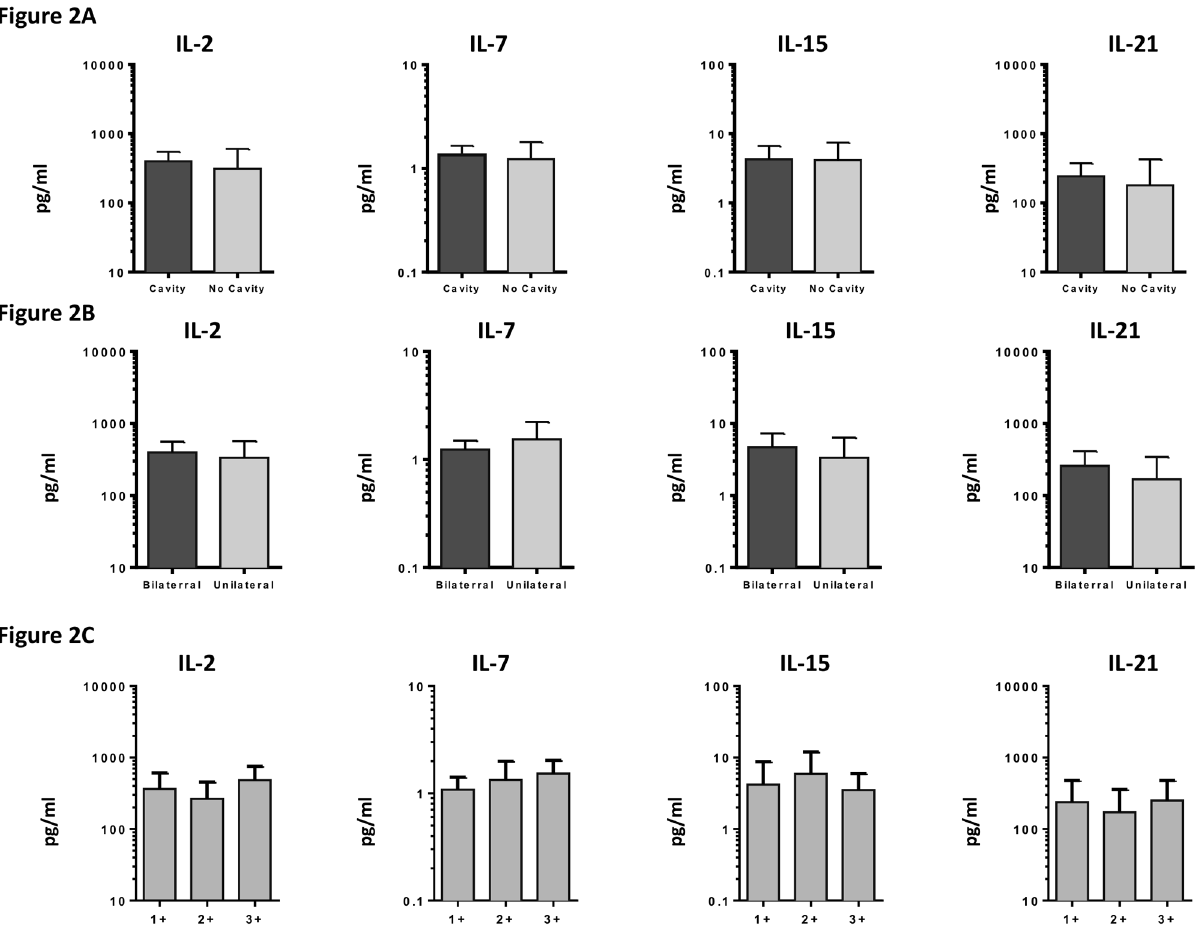
Fig 2. No association of common γ -chain cytokines circulating levels with extent of disease, disease severityor bacterial burdens in PTB individuals. (A) The plasma levels of common γ -chain cytokines IL-2, IL-7, IL-15 and IL-21 in PTB individuals with bilateralversus unilateraldisease,reflecting the extent of disease.(B) The plasma levels of common γ -chaincytokines IL-2, IL-7, IL-15 and IL-21 in PTB individualswith cavitary versus non-cavitary disease,reflecting the diseaseseverity. The data are represented as bar graphs showing geometricmeans and 95% confidenceintervals. P values were calculatedusing the Mann-Whitney test. (C) The relationshipbetweenthe plasma levels of common γ -chain cytokines IL-2, IL-7, IL-15 and IL-21 and smear gradesas estimated by sputum smears was examinedin PTB individuals.The data are representedas bar graphs showinggeometric means and 95% confidenceintervals. P values were calculated using linear trend post-test.